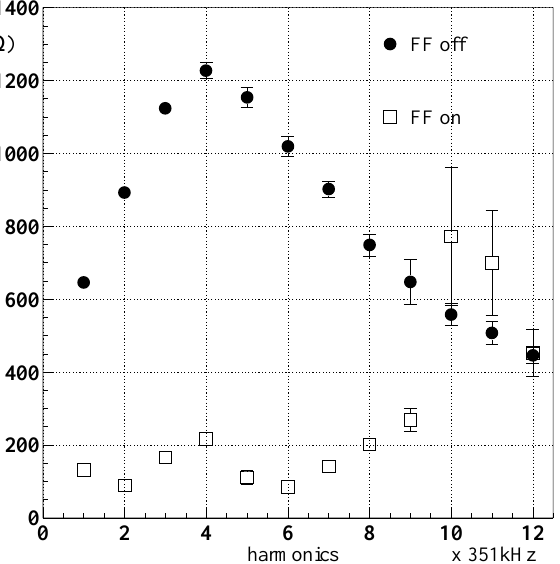
FIG. 5. Impedance per gap. The horizontal axis is the harmonics of a revolution frequency of 351 kHz. The black circles and the white squares are the impedance without and with feed forward, respectively. The error bars show statistical errors